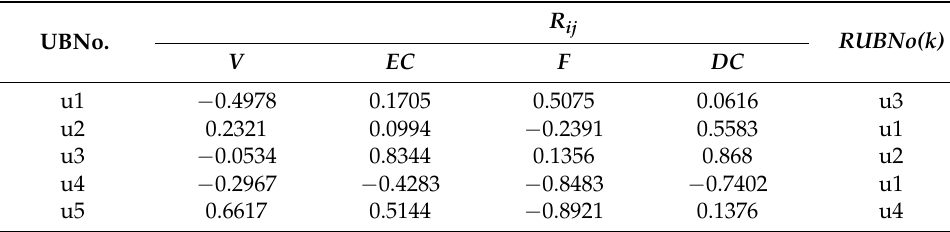
Table A13. Random number and selected unemployed bee for new solution (SUeNo.). UBNo.